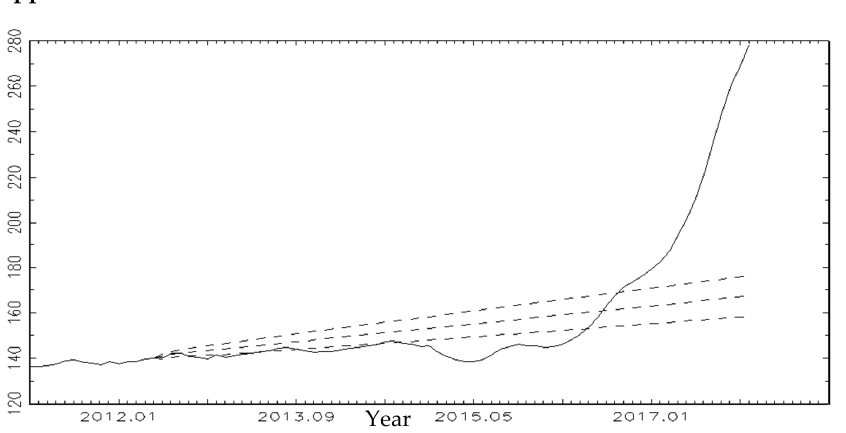
Figure A5. Time series forecasting for IPHIEA, the in-sample January 2000–May 2012, and the out-